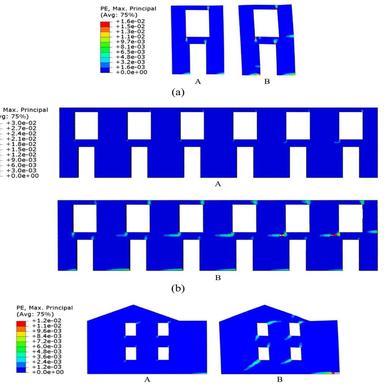
Principal plastic tensile strain contours for: (a) a single façade (b) a long-side continue façade (c) a short-side wall.